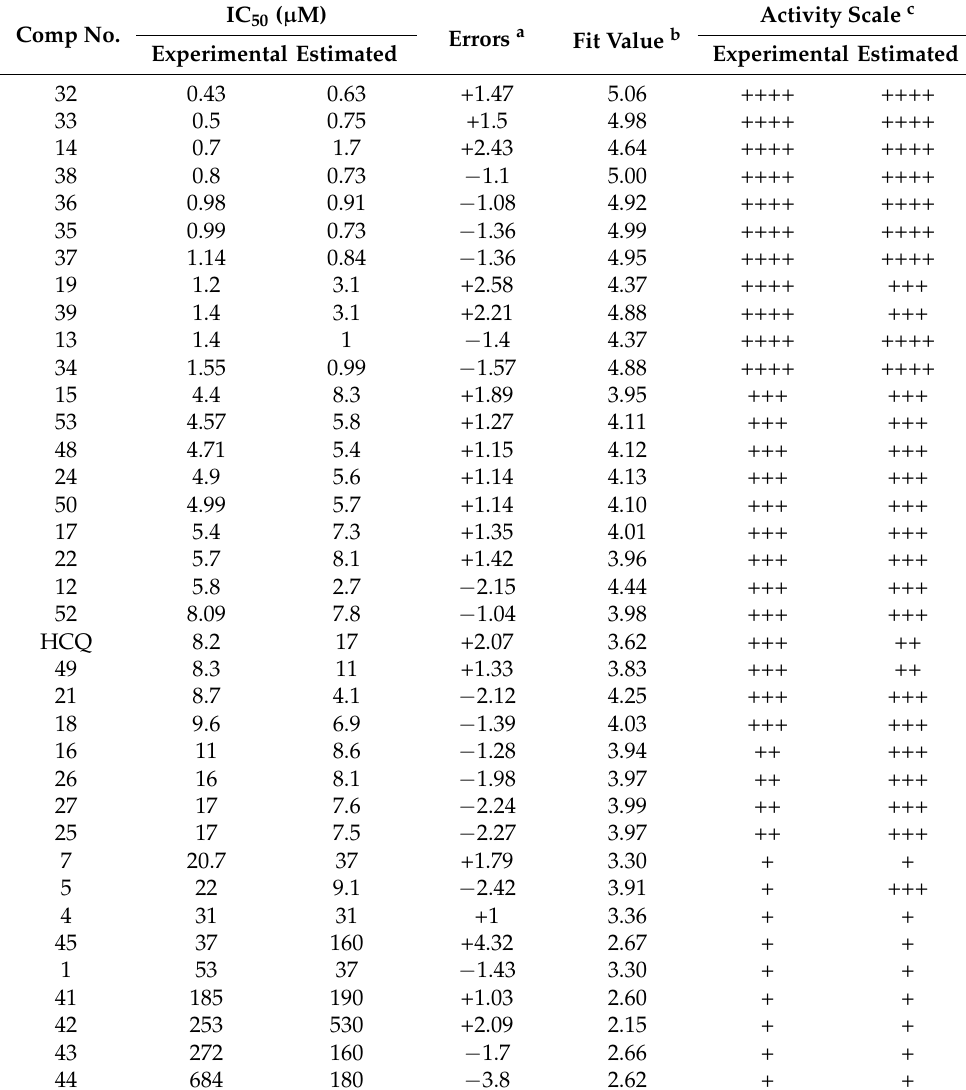
Table 2. Experimental and estimated activity values of the training set compounds based on best pharmacophore hypothesis, Hypo1. Comp